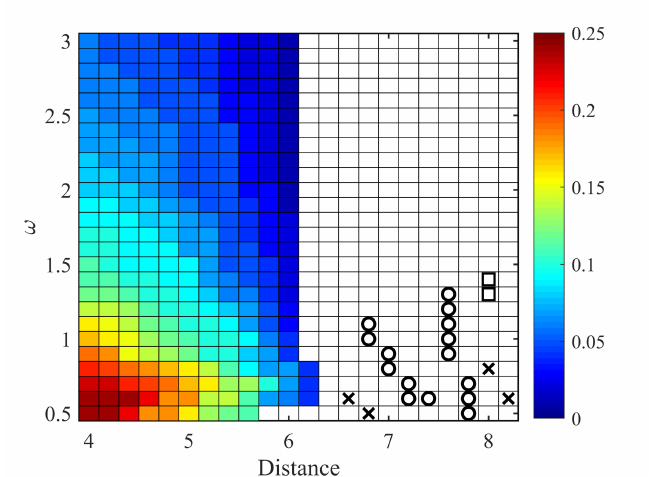
Figure 13 . Parameter space where a CSQ can form for a head-on collision between a Q-ball and an anti-Q-ball. The horizontal axis is the distance between the center of the initial Q-ball and anti-Q-ball, the vertical axis is the absolute value of the frequency of the initial Q-ball and anti-Q-ball, and the color bar denotes the maximum initial velocities allowed for a CSQ to form (251 bins for color values). The black symbols (crosses, circles and boxes) on the right are the special cases where a Q-ball and an anti-Q-ball with zero initial velocities collide to form two CSQs moving in opposite directions. The crosses, circles and boxes correspond to the cases where there are respectively 5, 3 and 2 charge swaps in the central lump before the two CSQs are formed and move